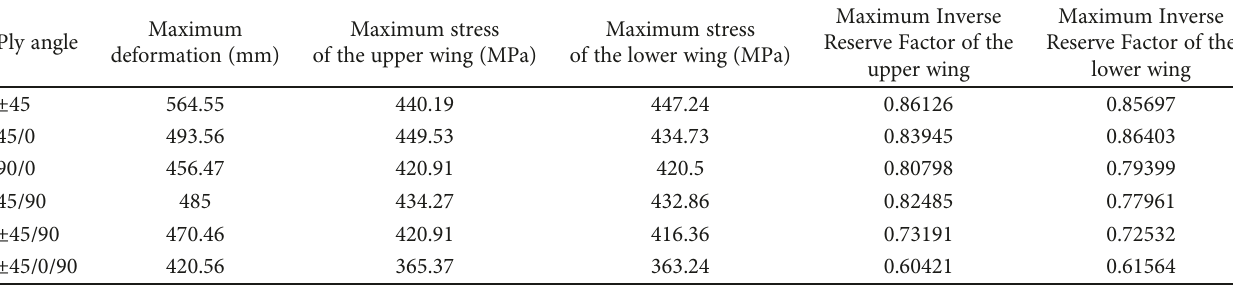
Figure 40: Stress cloud diagram of the lower wing with the layer angle being ± 45 and 90. Table 7: Structural performance of di ff erent ply angles.